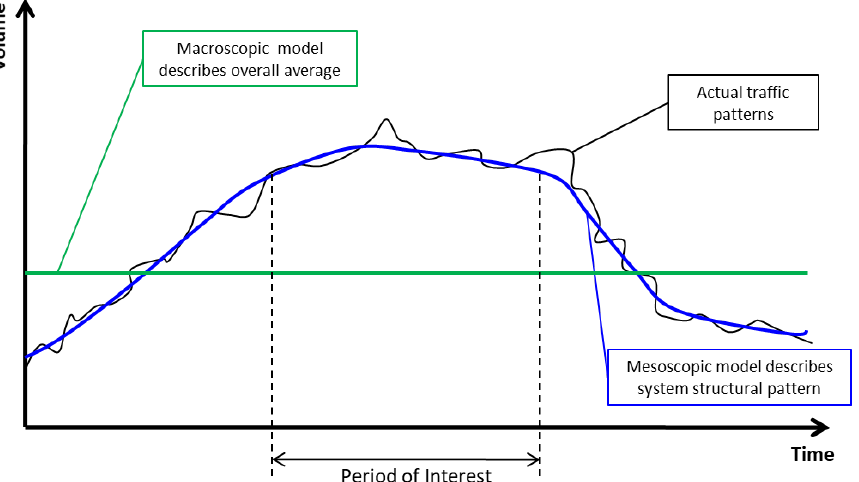
Figure 1: Departure time profile—macroscopic versus